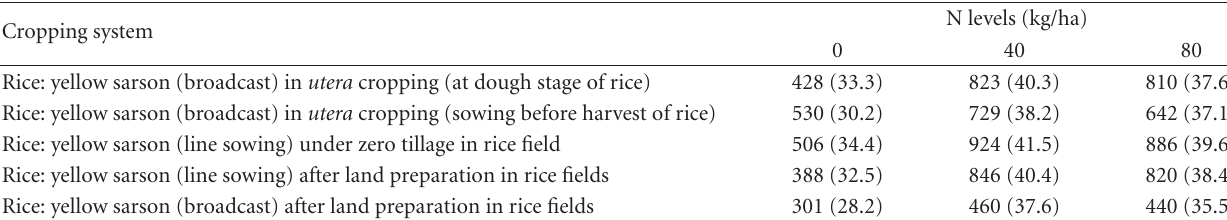
Table 4: Seed yield (kg/ha) and oil content (%) of toria as influenced by di ff erent N levels in utera cropping system at Bhubaneshwar. Cropping system